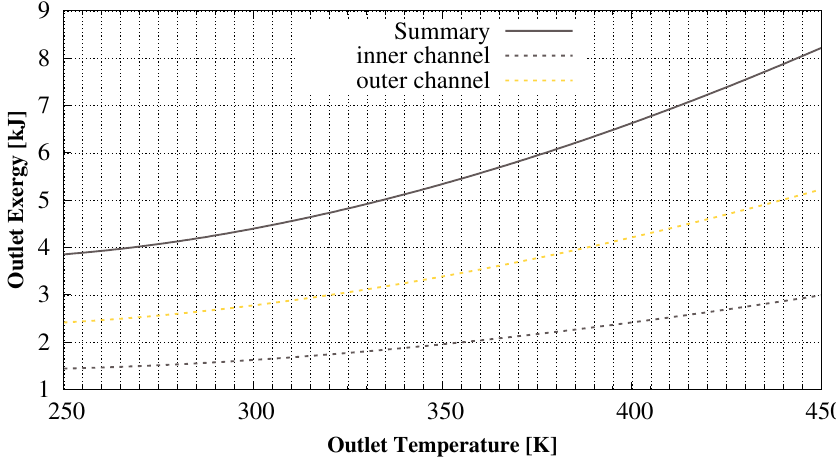
Figure 20. Outlet pressure and temperature time